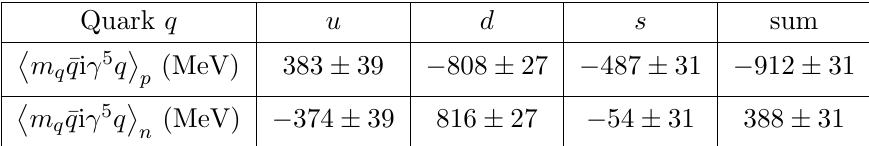
Table 7 . Nucleon matrix elements of pseudoscalar quark operators m q (cid:22) qi(cid:13) 5 q . Open